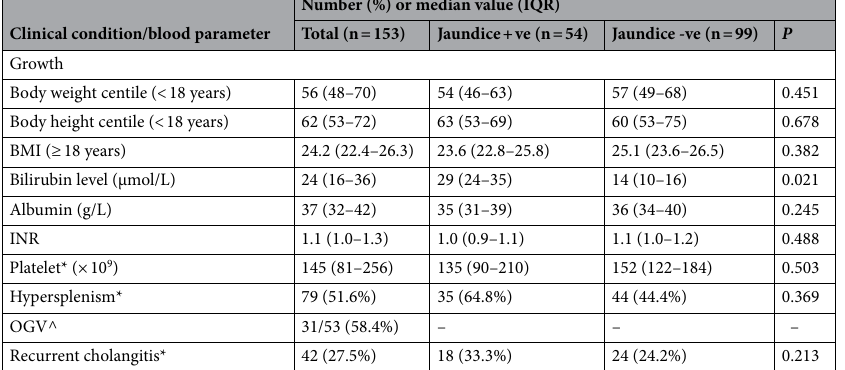
Table 3. The latest clinical conditions of the 153 native liver survivors of BA. Jaundice is defined as total serum bilirubin level > 20 µmol/L. *Percentage calculated based on 153 native liver survivors. ^As the percentage was calculated based on the 53 patients who have received upper endoscopy, the comparison between jaundice + ve and − ve was not